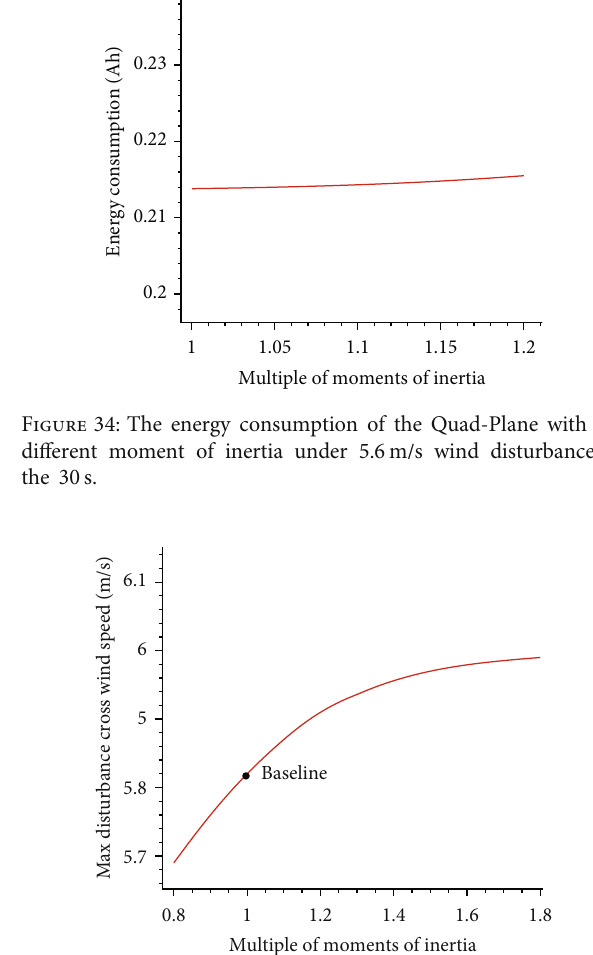
Figure 35: Crosswind disturbance rejection of the Quad-Plane performance with the di ff erent moment of inertias.